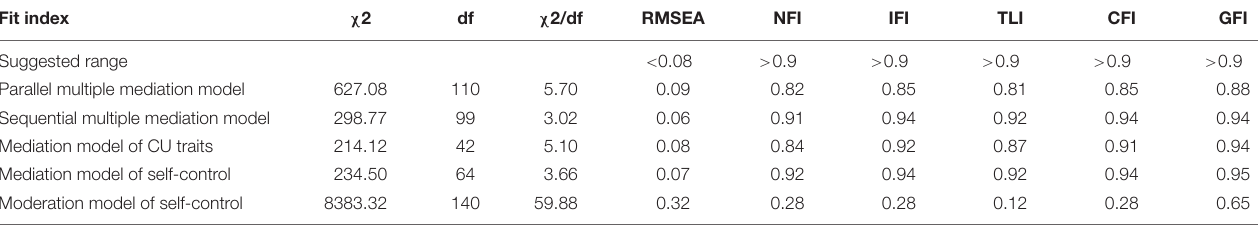
TABLE 4 | Model fit indices for each model.